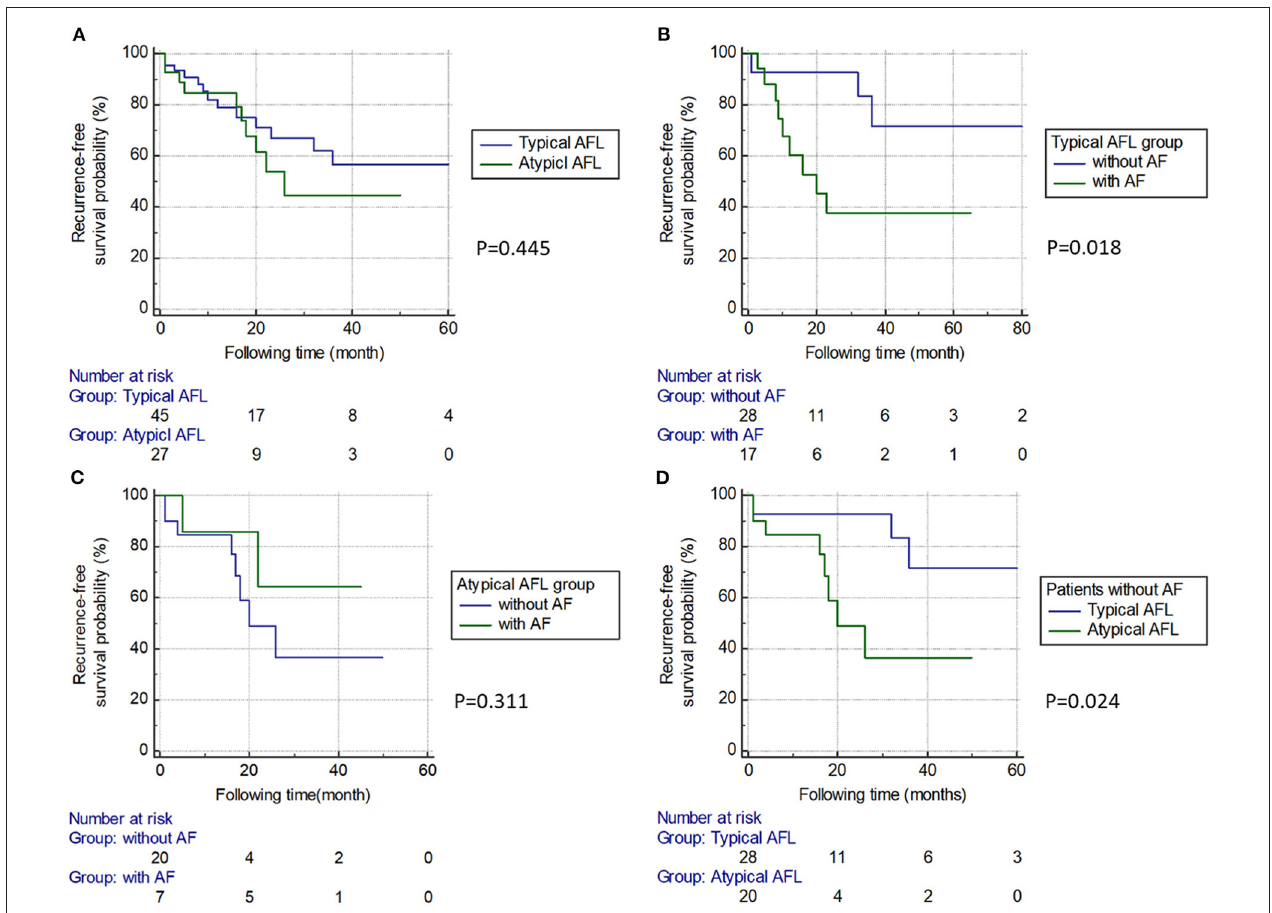
FIGURE 3 | Kaplan–Meier survival curve between subgroups. (A) The typical and atypical AFL groups. There was no significant difference in the recurrence-free survival rate between the two groups. (B) Subgroups of patients with or without AF in the typical AFL group. Patients with AF had a higher recurrence rate than those without. (C) Subgroups of patients with or without AF in the atypical AFL group. There was no significant difference in the recurrence-free survival rate between the two groups. (D) In patients without AF, the atypical AFL group had a higher recurrence rate than the typical AFL group. AFL, atrial flutter; AF, atrial